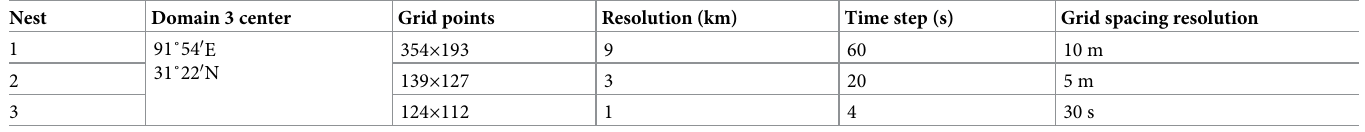
(encompassing 61 days). The 6-h NCEP FNL analysis dataset from the Global Forecast System (GFS) provided both the initial and lateral boundary conditions for the WRF simulations. The resolution of FNL data is 0.25 degree. We used WPS in WRF model to process the same resolu- tion to run the model. The configurations of the nested domains are listed in Table 1. Case 1: This experiment used the default values for all parameters of the WRF model. The domain was designed based on the USGS (United States Geological Survey) 1-km terrain data, and the soil parameters were obtained from the National Centers for Environmental Predic- tion (NECP) FNL (DOI: 10.5065/D6M043C6) analysis dataset (Wei Wang et al., 2012). Case 2: In this case, the initial SM values were changed in the first layer of WRF model using the Noah land surface model and based on AMSR-E SM data. After checking the initial SM values of the model, we found that the model SM values were higher than the observed val- ues. Therefore, the SM of the WRF model was transformed using AMSR-E SM data in this case. Because the Nagqu area is relatively flat and consists of a uniform land surface, the AMSR-E SM data can be used to represent a large area of the Tibetan Plateau. Therefore, we replaced the SM data in the first layer with the Noah SM data; for example, SM was replaced with SM000010 in the WRF model. That is to say AMSR-E products can deirctly replace the FNL dataset in the model WPS part every 6 hours. The objective of case 2 was to identify the Table 1. Nested domain for the modeling area. Nest Domain 3